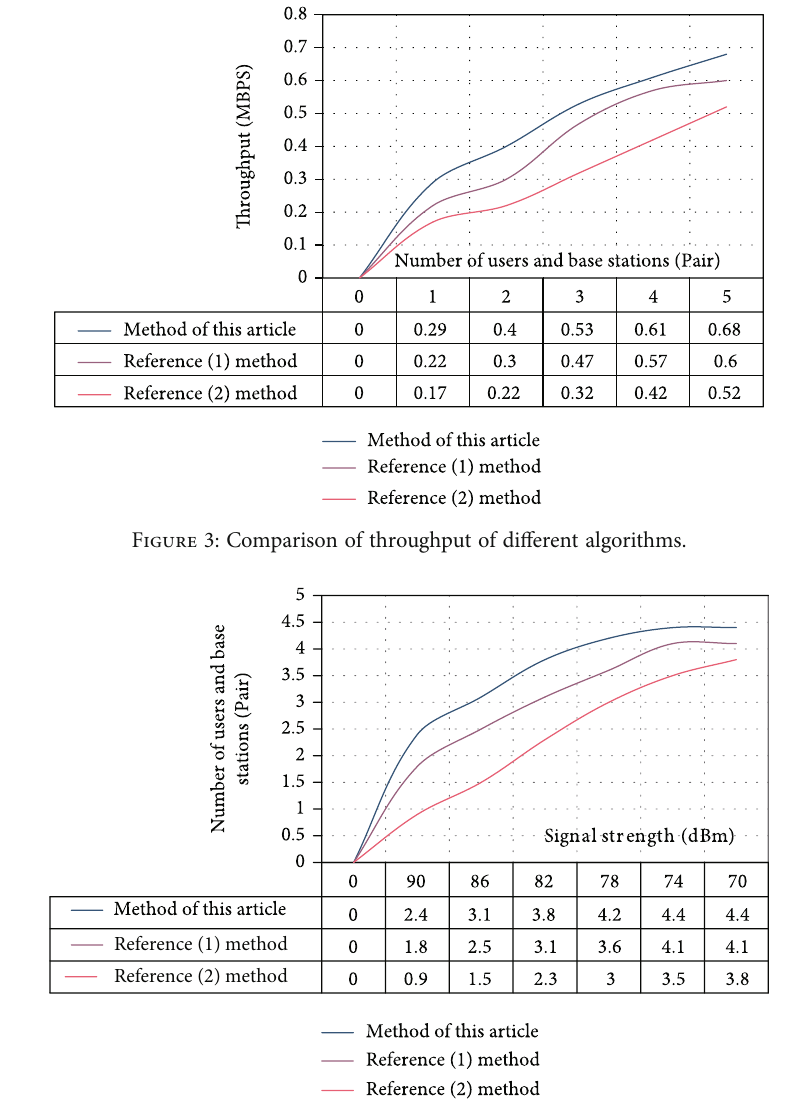
Figure 4: Comparison of user communication under di ff erent signal